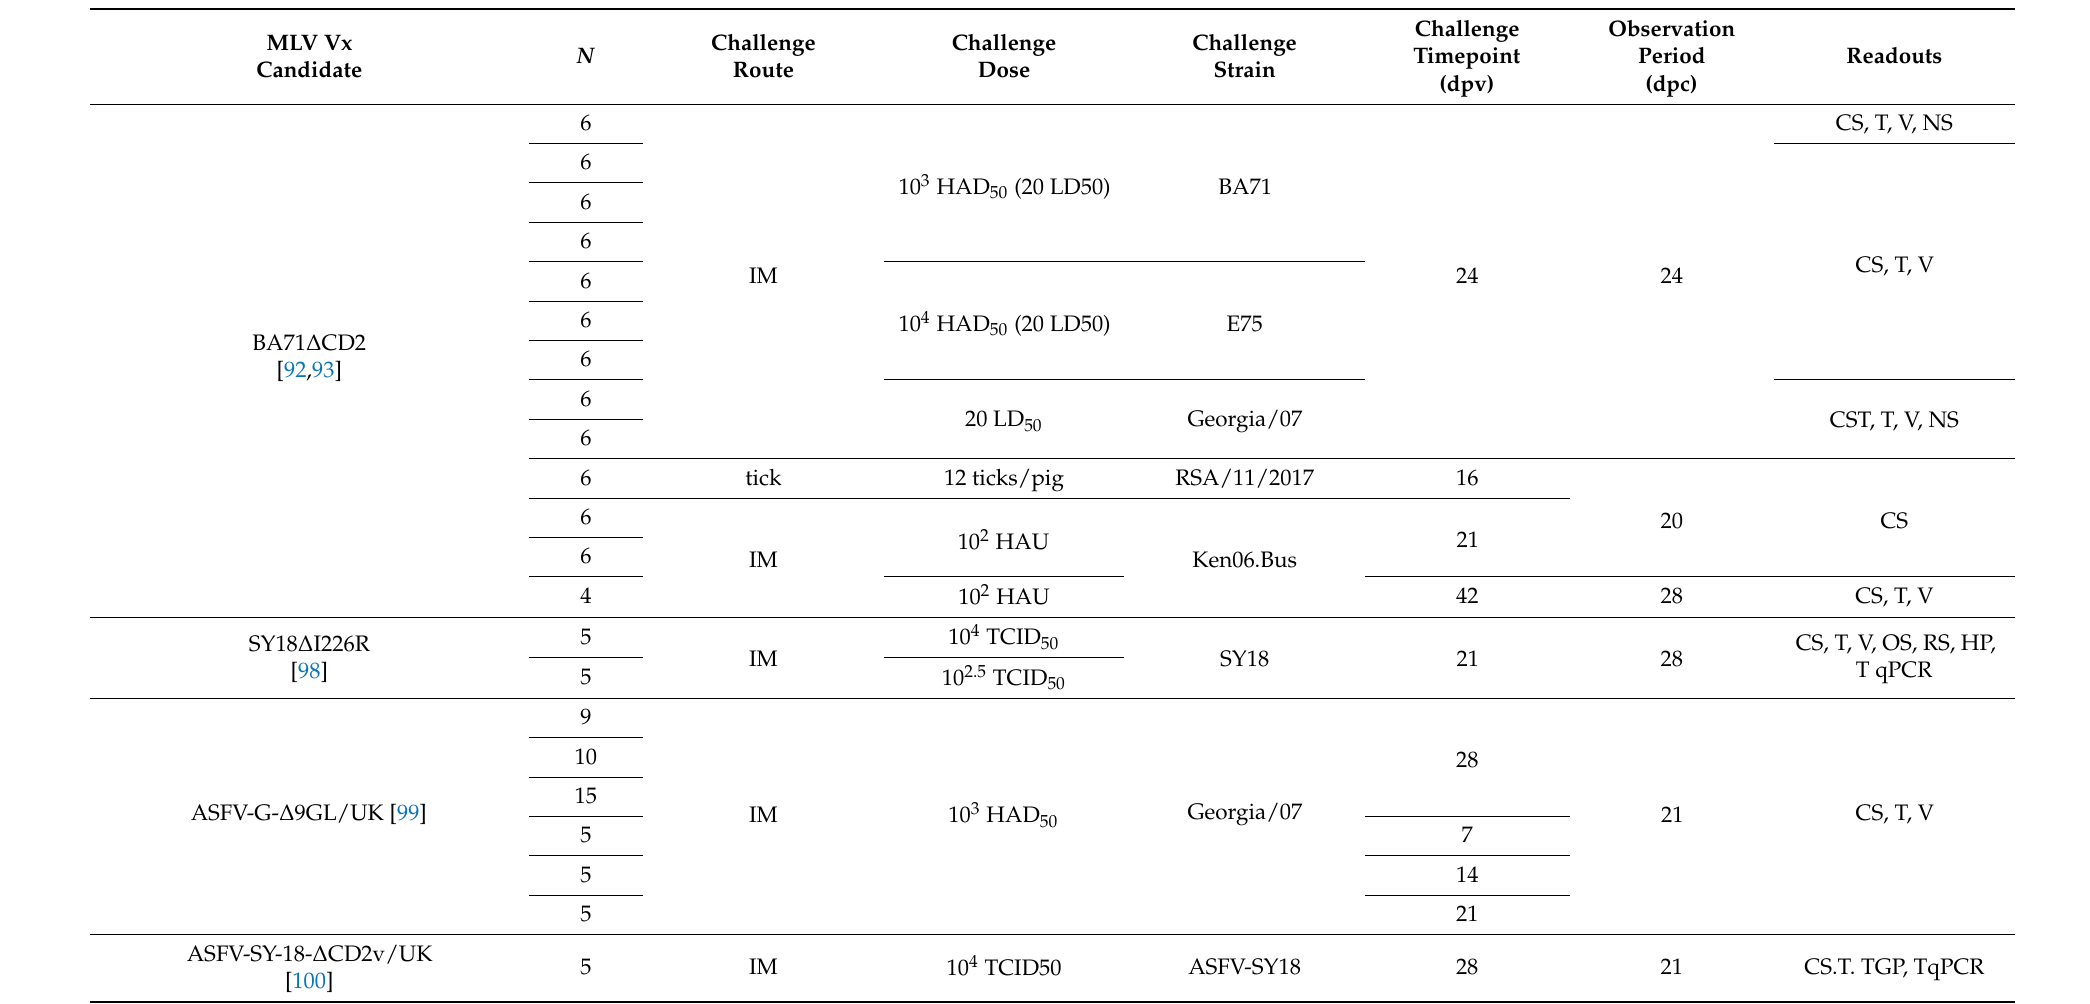
Table 3. Clinical Models to Assess MLV Vaccine Candidate